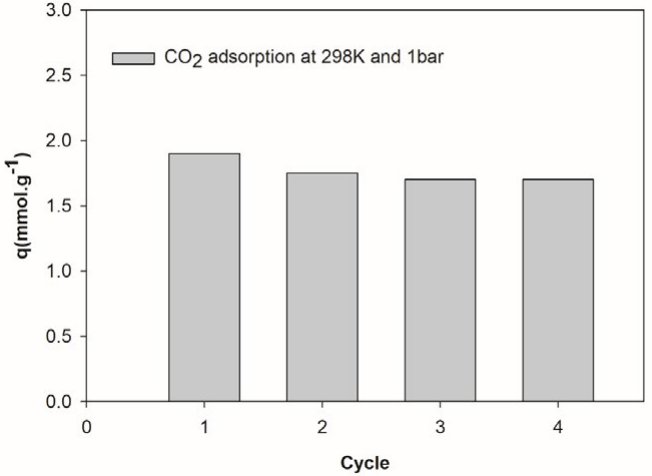
Fig. 8. Cyclic adsorption-desorption tests.